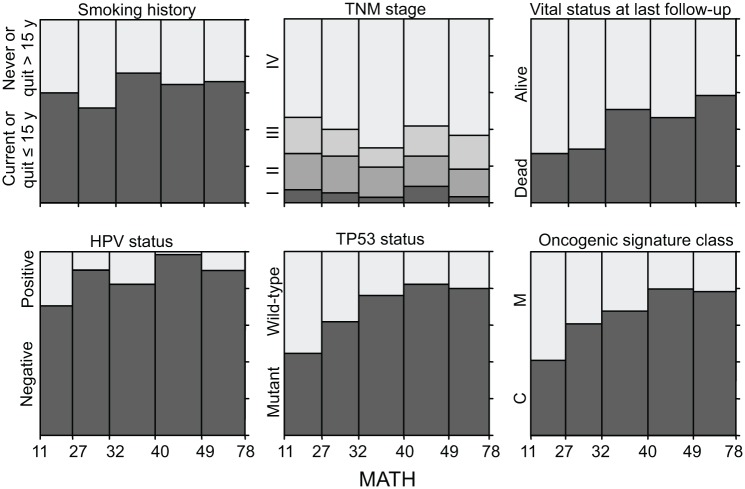
Relations of selected clinical and molecular characteristics to MATH values.Each panel represents the relation of a clinical or molecular characteristic to MATH values. Within each panel, the horizontal axis represents the range of tumor MATH values, divided into five groups with approximately equal numbers of tumors. The relative heights of the shaded portions within each vertical bar indicate the proportions of cases having the indicated characteristics.